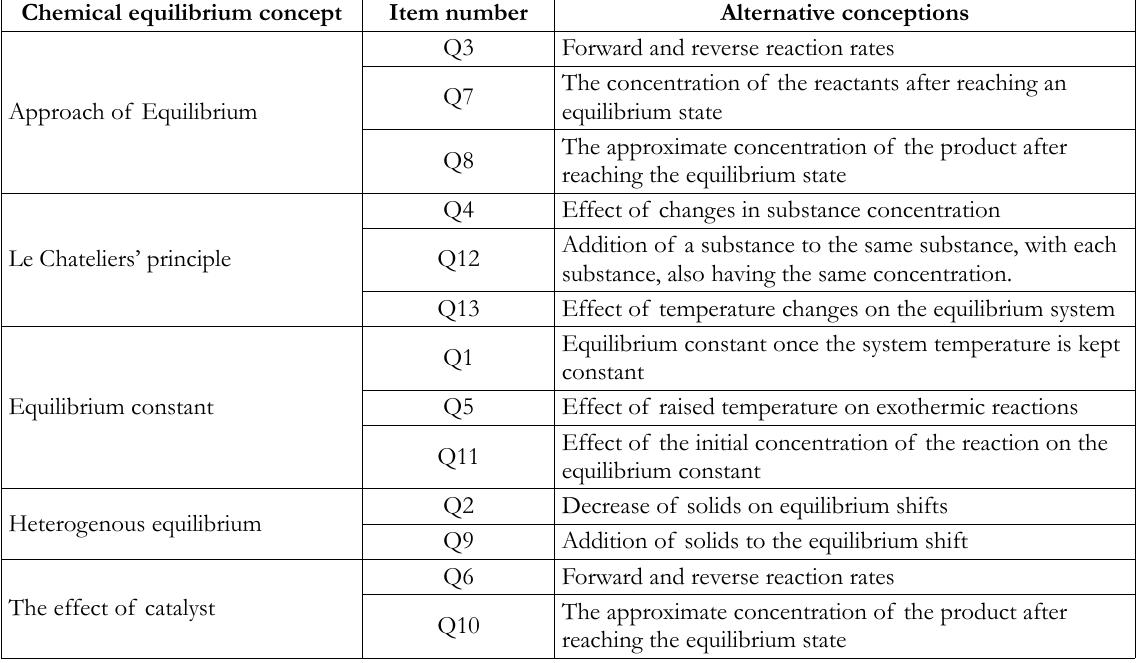
Table 1. Areas of alternative